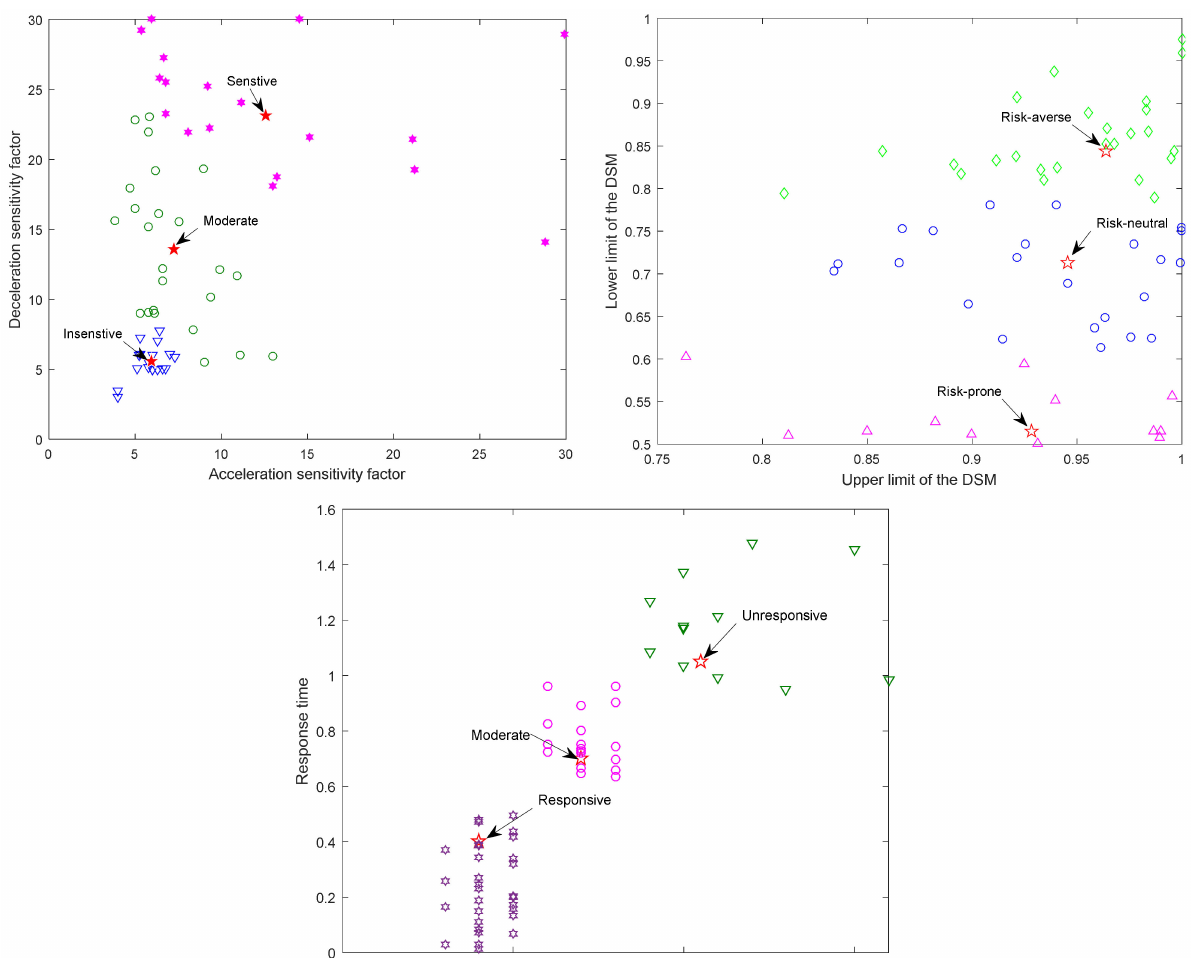
Figure 1. Classification of DBCs.